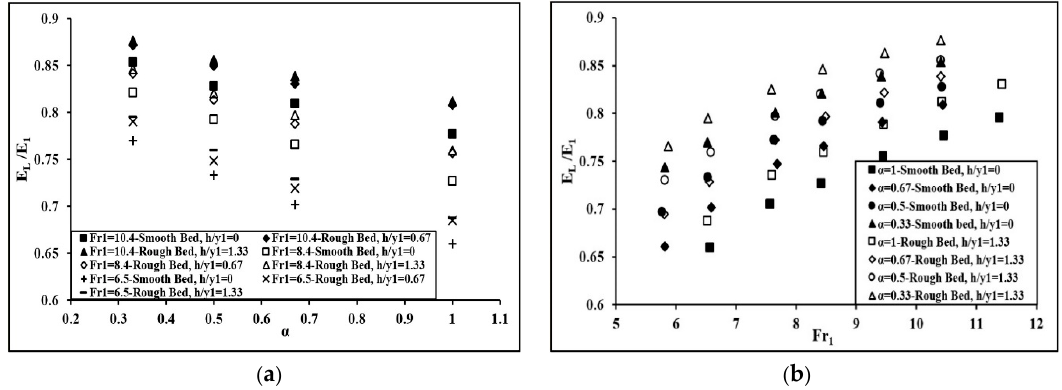
Figure 20. Variation of energy dissipation on the smooth and rough bed ( a ) with expansion ratios for different upstream Froude numbers, ( b ) with upstream Froude numbers for different expansion ratios. The following empirical equation obtained by non-linear regression with the value of R 2 =